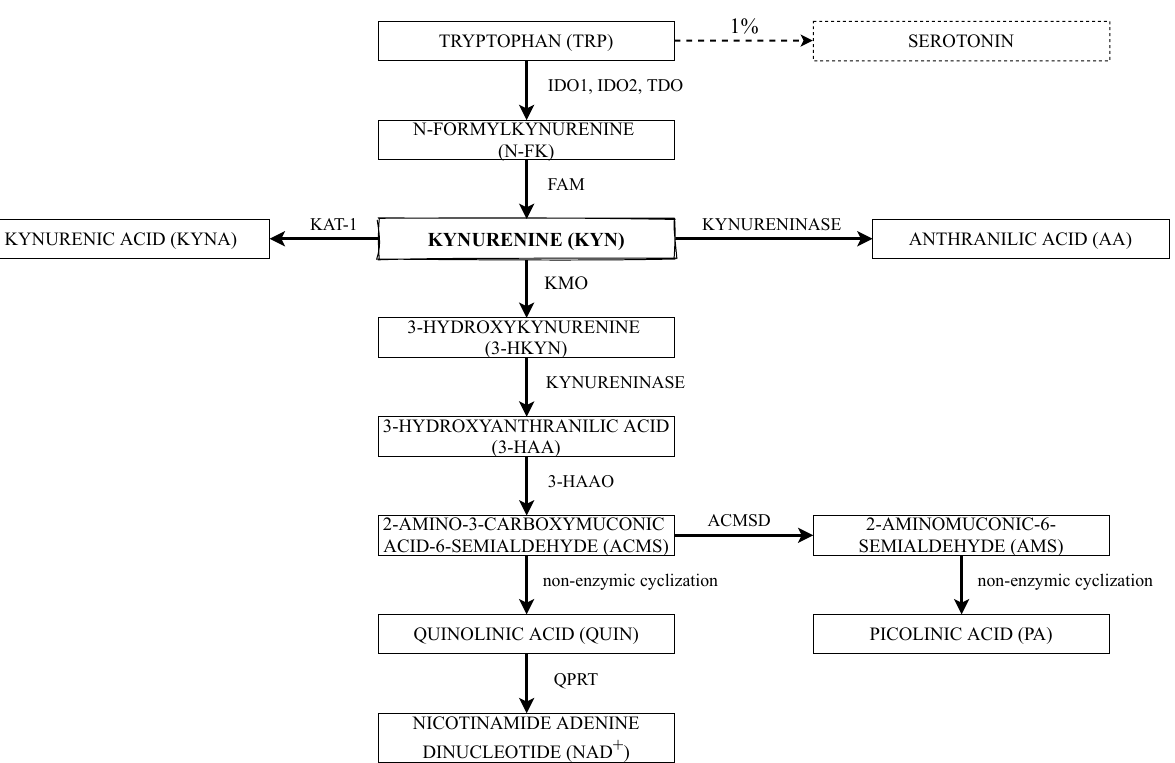
Figure 1. Schematic representation of the kynurenine metabolic pathway. Abbreviations: FAM—N-formylkynurenine formamidase; IDO1—indoleamine 2,3-dioxygenase 1; IDO2—indoleamine 2,3-dioxygenase 2; TDO—tryptophan 2,3- dioxygenase; KMO—kynurenine 3-monooxygenase; 3-HAAO—3-hydroxyanthranilate 3,4-dioxygenase; ACMSD—2- aminomuconic acid semialdehyde dehydrogenase; QPRT—quinolinic acid